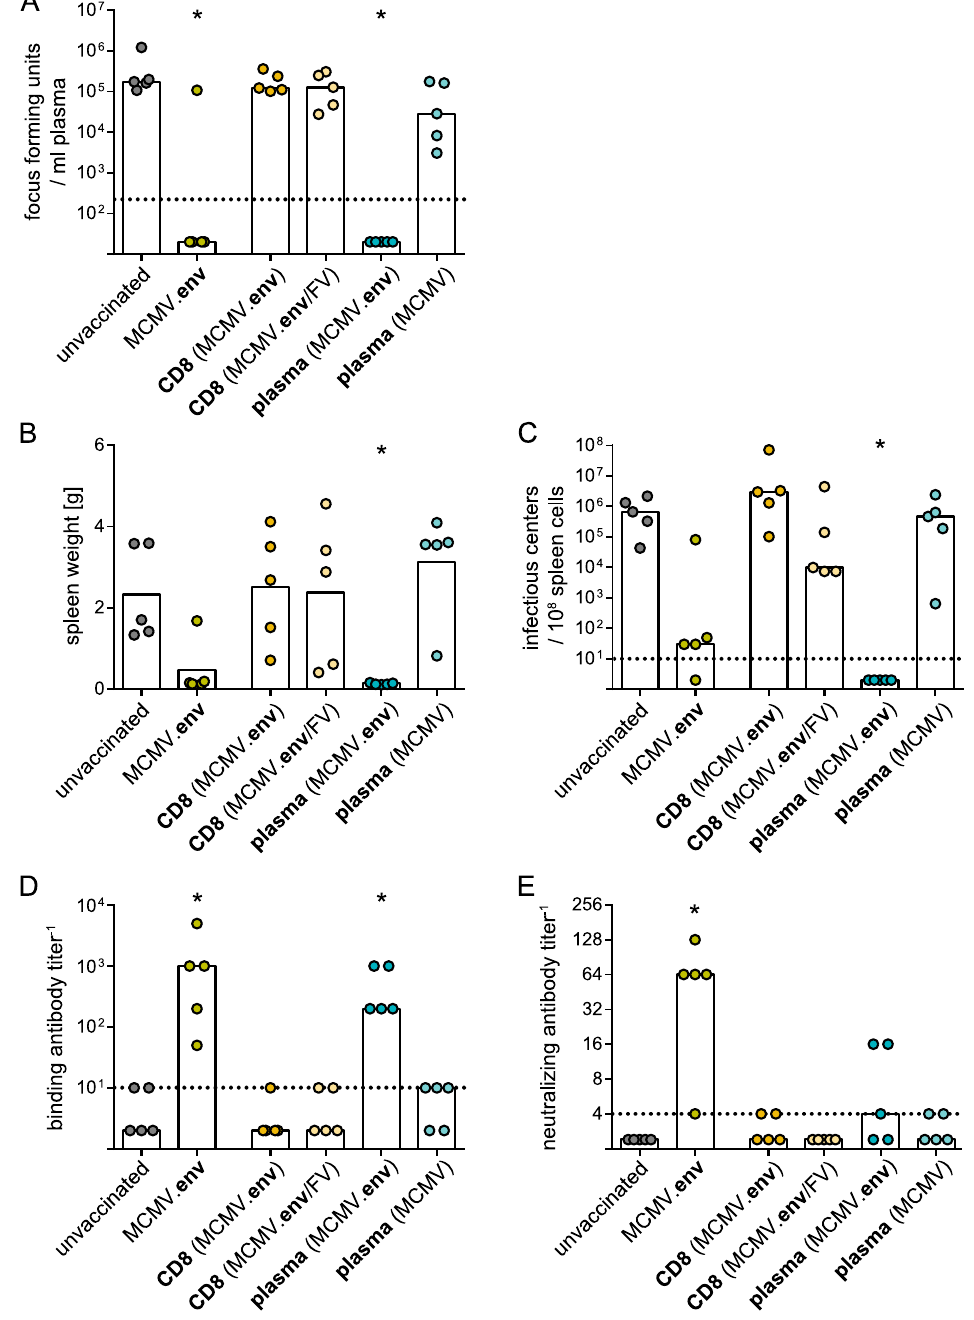
Fig 10. Transfer of plasma confers protection. Donor CB6F1 mice were immunized once with MCMV or MCMV.env and infected with 5 000 SFFU FV six weeks later. CD8 + T cells were isolated from spleens of MCMV.env immunized mice either six weeks after immunization, or two weeks after FV challenge infection and transferred into na ï ve recipient CB6F1 mice. Plasma was isolated from MCMV or MCMV.env immunized mice two weeks after FV challenge infection and transferred into na ï ve recipient CB6F1 mice. One day after the transfer of plasma or CD8 + T cells mice were infected with 5 000 SFFU FV. MCMV.env immunized mice and unvaccinated mice served as controls and were infected with 5 000 SFFU FV at the same time. Viral loads in plasma (A) was analysed ten days after FV challenge, spleen weights (B) and spleen viral loads (C) were analysed three weeks after FV challenge. Binding (D) and neutralizing antibody titers (E) were analysed ten days after FV challenge. Data were obtained in one experiment, each dot indicates one mouse, bars indicate median (A, C-E) or mean (B) values. Statistically significant differences compared to unvaccinated mice are indicated by � ( P < 0.05, One Way ANOVA on Ranks, Dunn’s post test).